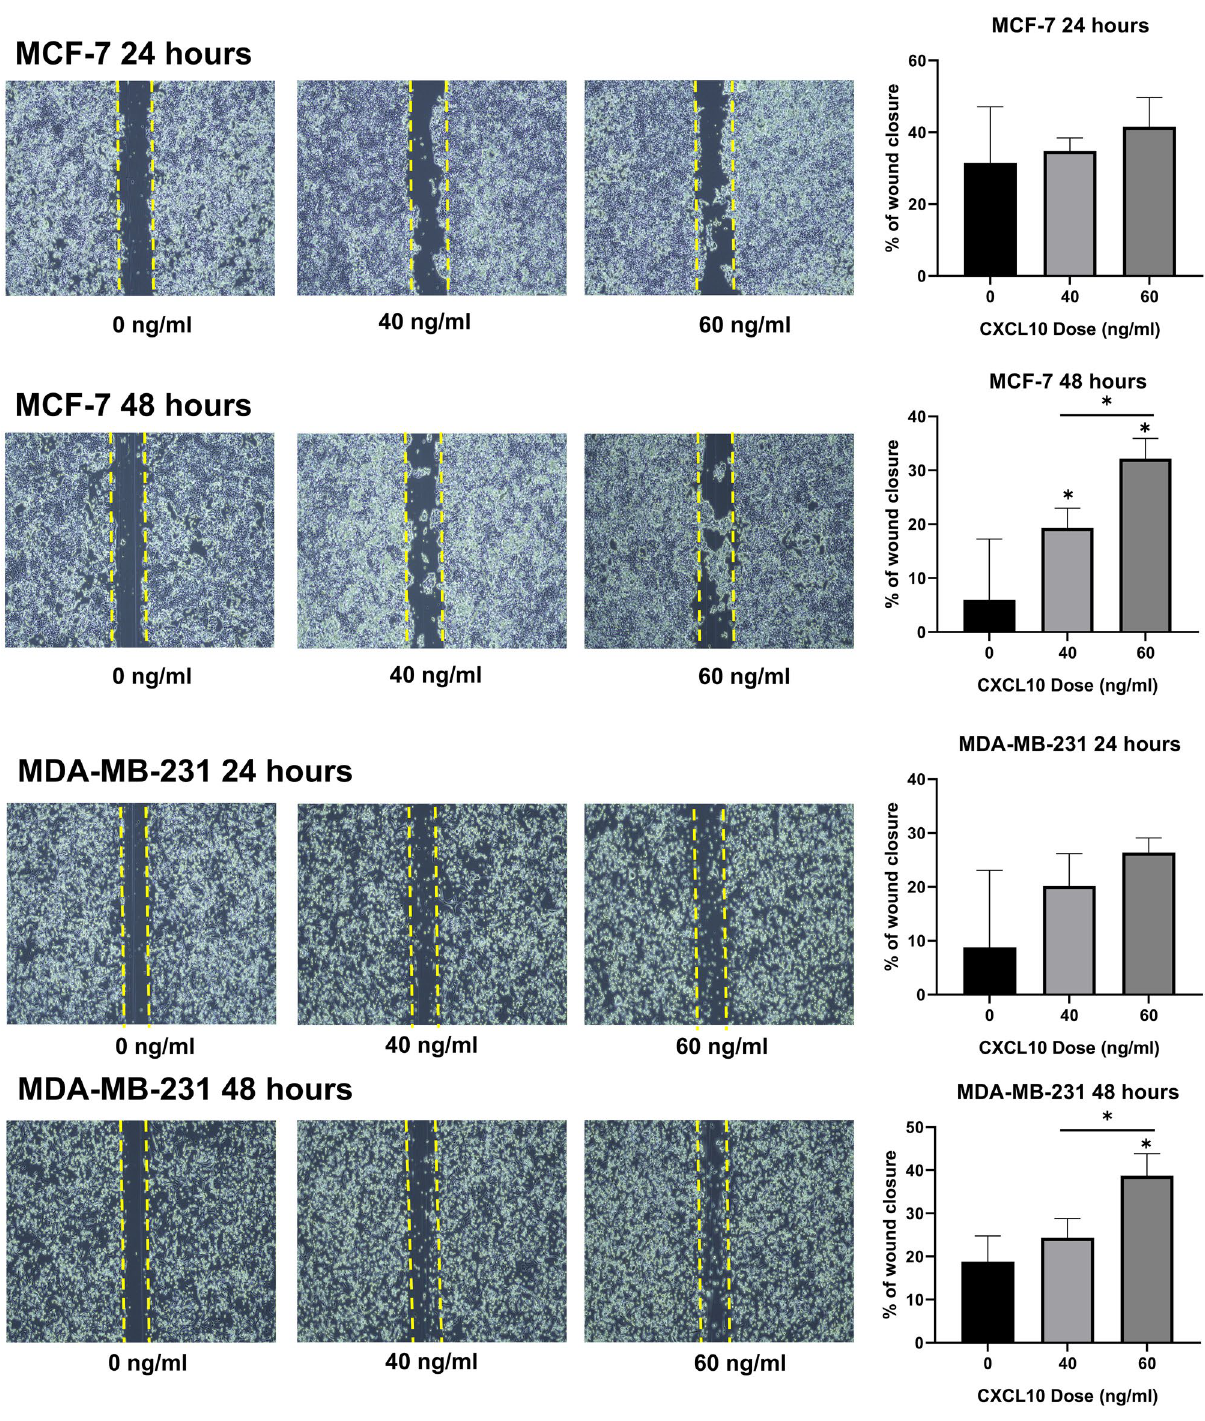
Figure 3. Cell migration with CXCL10 treatment. In MCF-7, cell migration increased in a stepwise manner after 24 h although statistically non-significant. After 48 h, the percentage of wound closure significantly increased with 40 ng/ml and 60 ng/ml of CXCL10 with p < 0.05 , respectively. MDA-MB231 showed an increased percentage of wound closure after 24 h and 48 h after CXCL10 was added. After 48 h, the sample with 60 ng/ml of CXCL10 showed significantly increased wound closure ( p < 0.05). *Statistically significant. The graphs were created using GraphPad Prism version 8.02 for Windows (GraphPad Sofware, San Diego, CA, USA, www. graph pad.